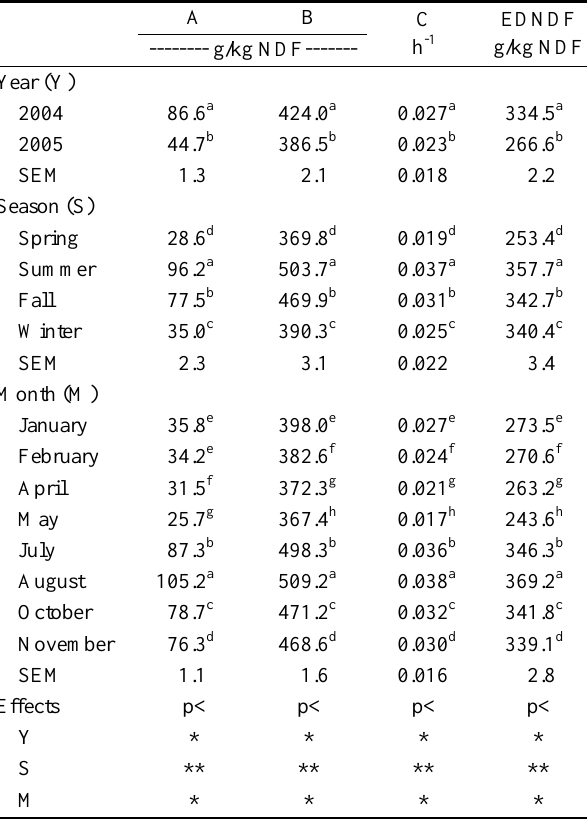
Table 5. In situ degradability and effective degradability of dry matter of the diet consumed by grazing